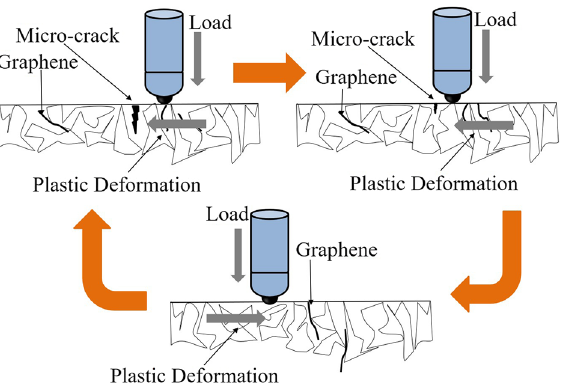
Figure 8. Schematic illustration of the corrosion solution causing micro-cracks in the oxide film